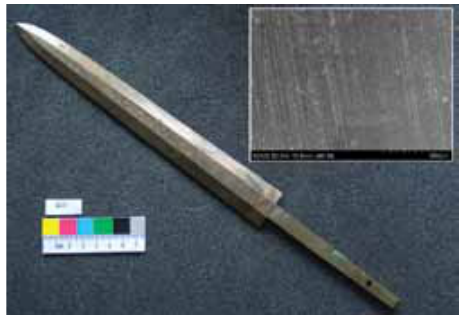
Fig. 12: A bronze lance from the Terracotta Army, with (inset) SEM image of a silicon rubber impression taken on a lance blade, showing the fine pol- ishing marks; their density and par- allel arrangement denote the use of a rotary mechanical faces in order to improve the functioning of the trigger; however, one of the most impres- sive technical discoveries made through the study of rubber impressions concerns the